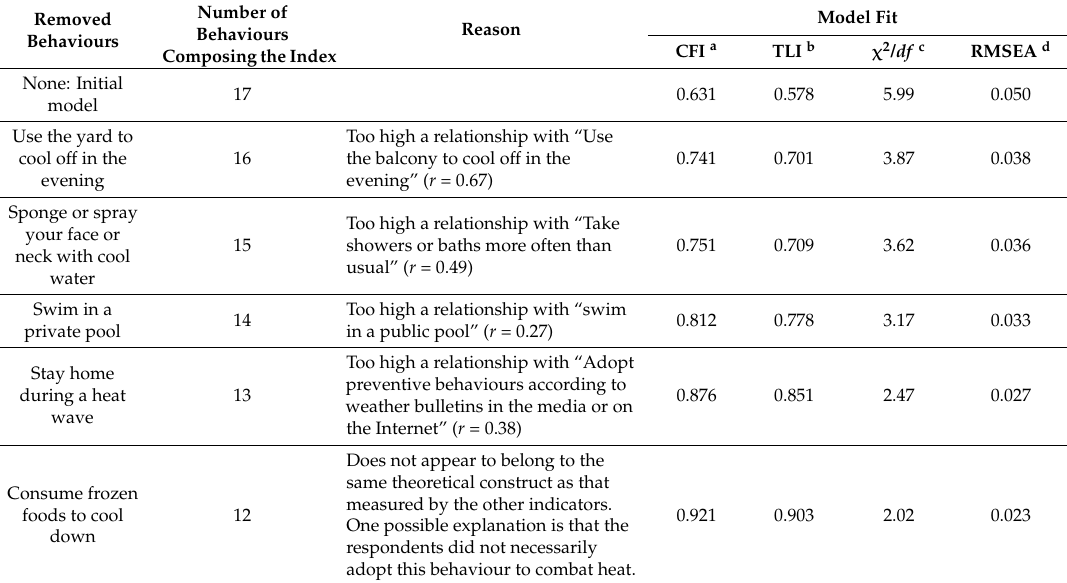
Table 2. Indicators removed from the CFA model.